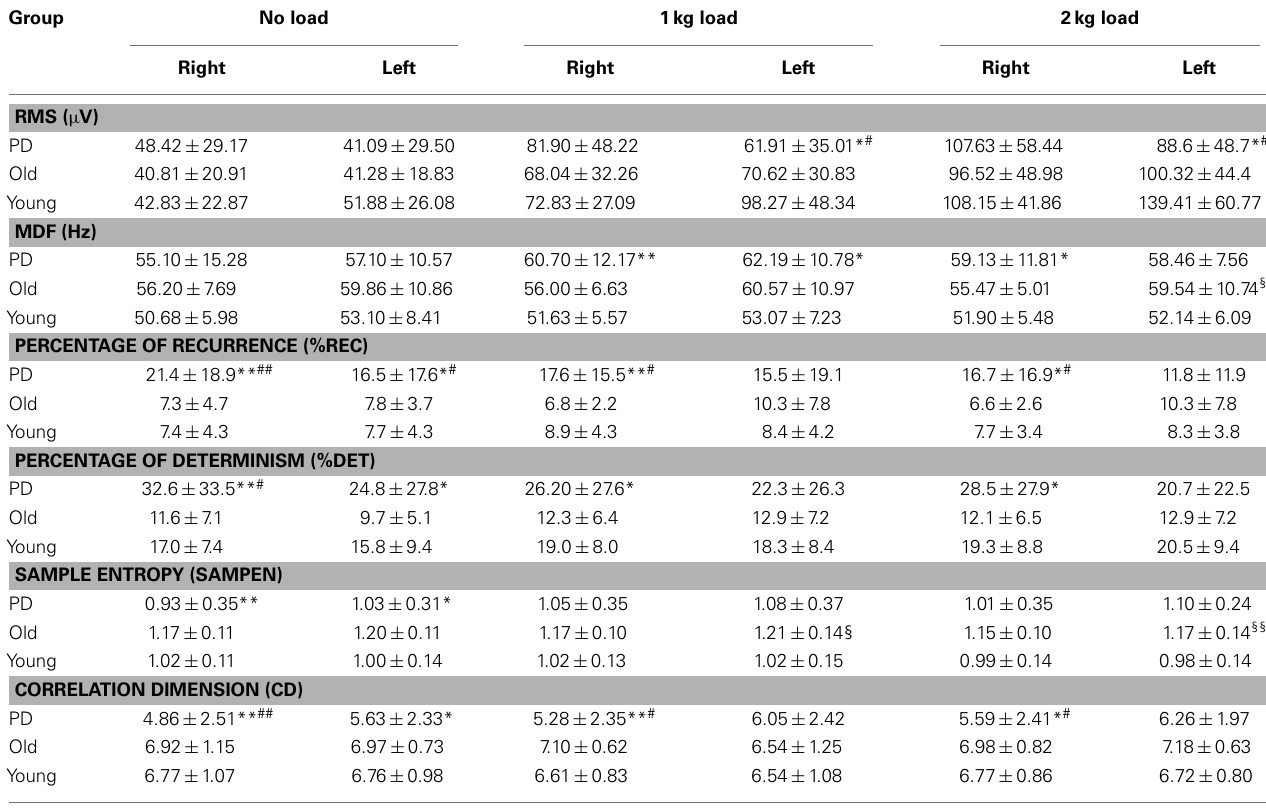
Table 1 |The linear and non-linear SEMG parameters of PD patients and healthy old and young control subjects. Group No load 1kg load 2kg load Right Left Right Left Right